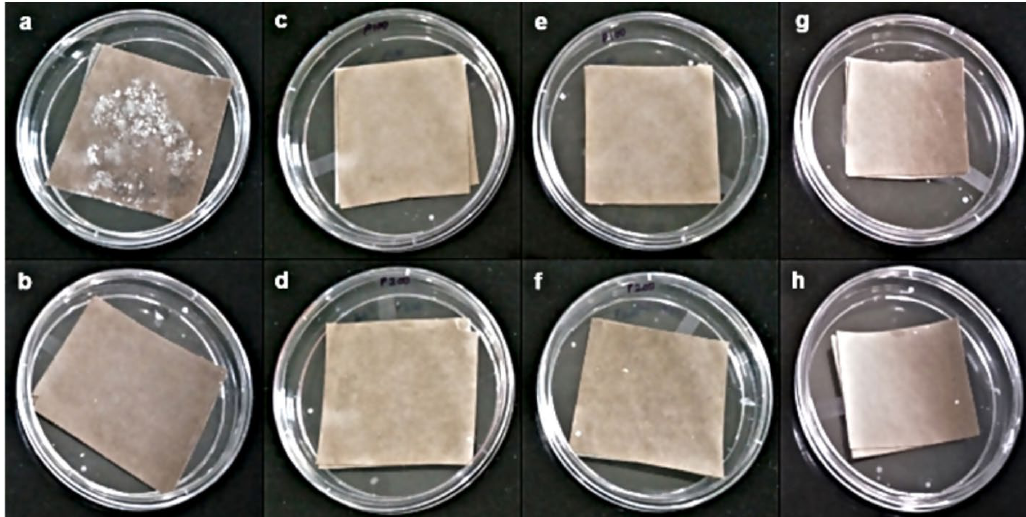
Fig. 4. Application of LPE+Nisin for cardboard preservation a. Corrugated cardboard with ‘no inhibition’ of microbial growth. Cardboard coated with b. 1% (w/w) salicylic acid c. 15 (w/w) LPE+Nisin at 25°C d. 2 % (w/w) LPE+Nisin at 25 °C e. 1 % (w/w) LPE+Nisin incubated at 37 °C f. 2 % (w/w) LPE+Nisin incubated at 37 °C g. 1 % (w/w) LPE+Nisin incubated at 55 °C h. 2 % (w/w) LPE+Nisin incubated at 55°C observed after 180 days of